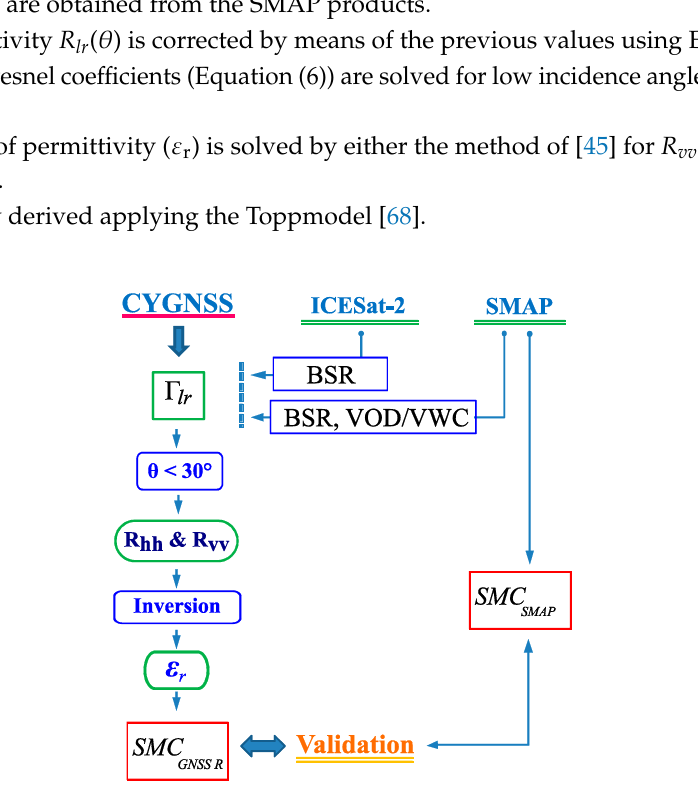
Figure 6. Flowchart of GNSS-R SMC retrieval methodology.